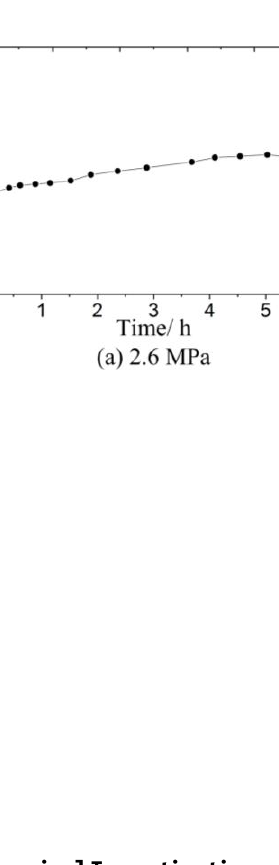
Figure 8. Thermal efficiency of receiver during start-up process.